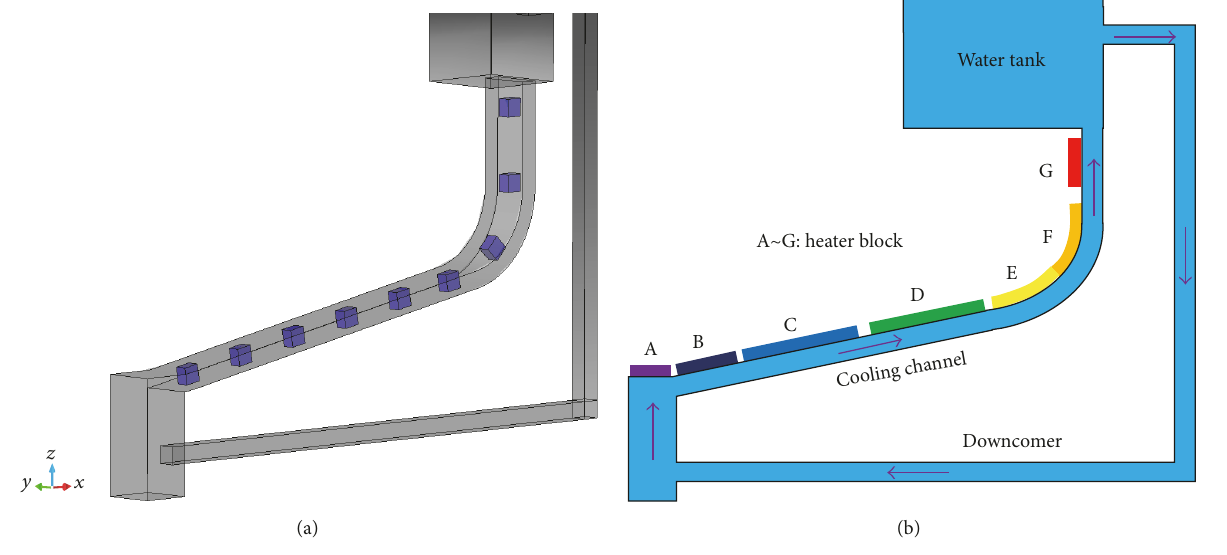
Figure 3: Studs (a) and heating blocks (b) in the cooling channel. Table 1: Initial and boundary conditions for the selected